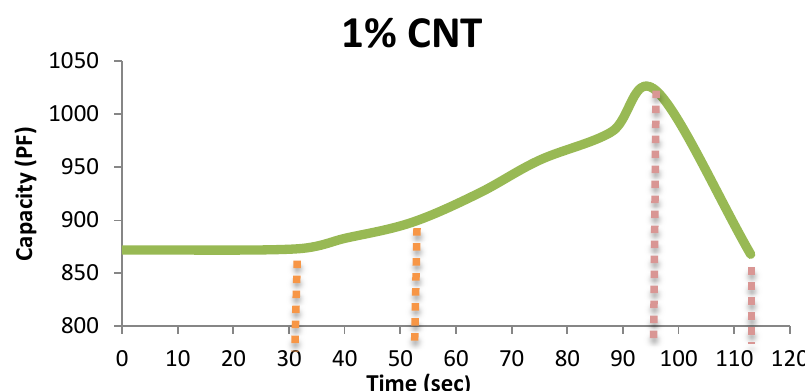
Fig.10: Response time and recovery time for humidity sensor with 1wt% MWCNT.